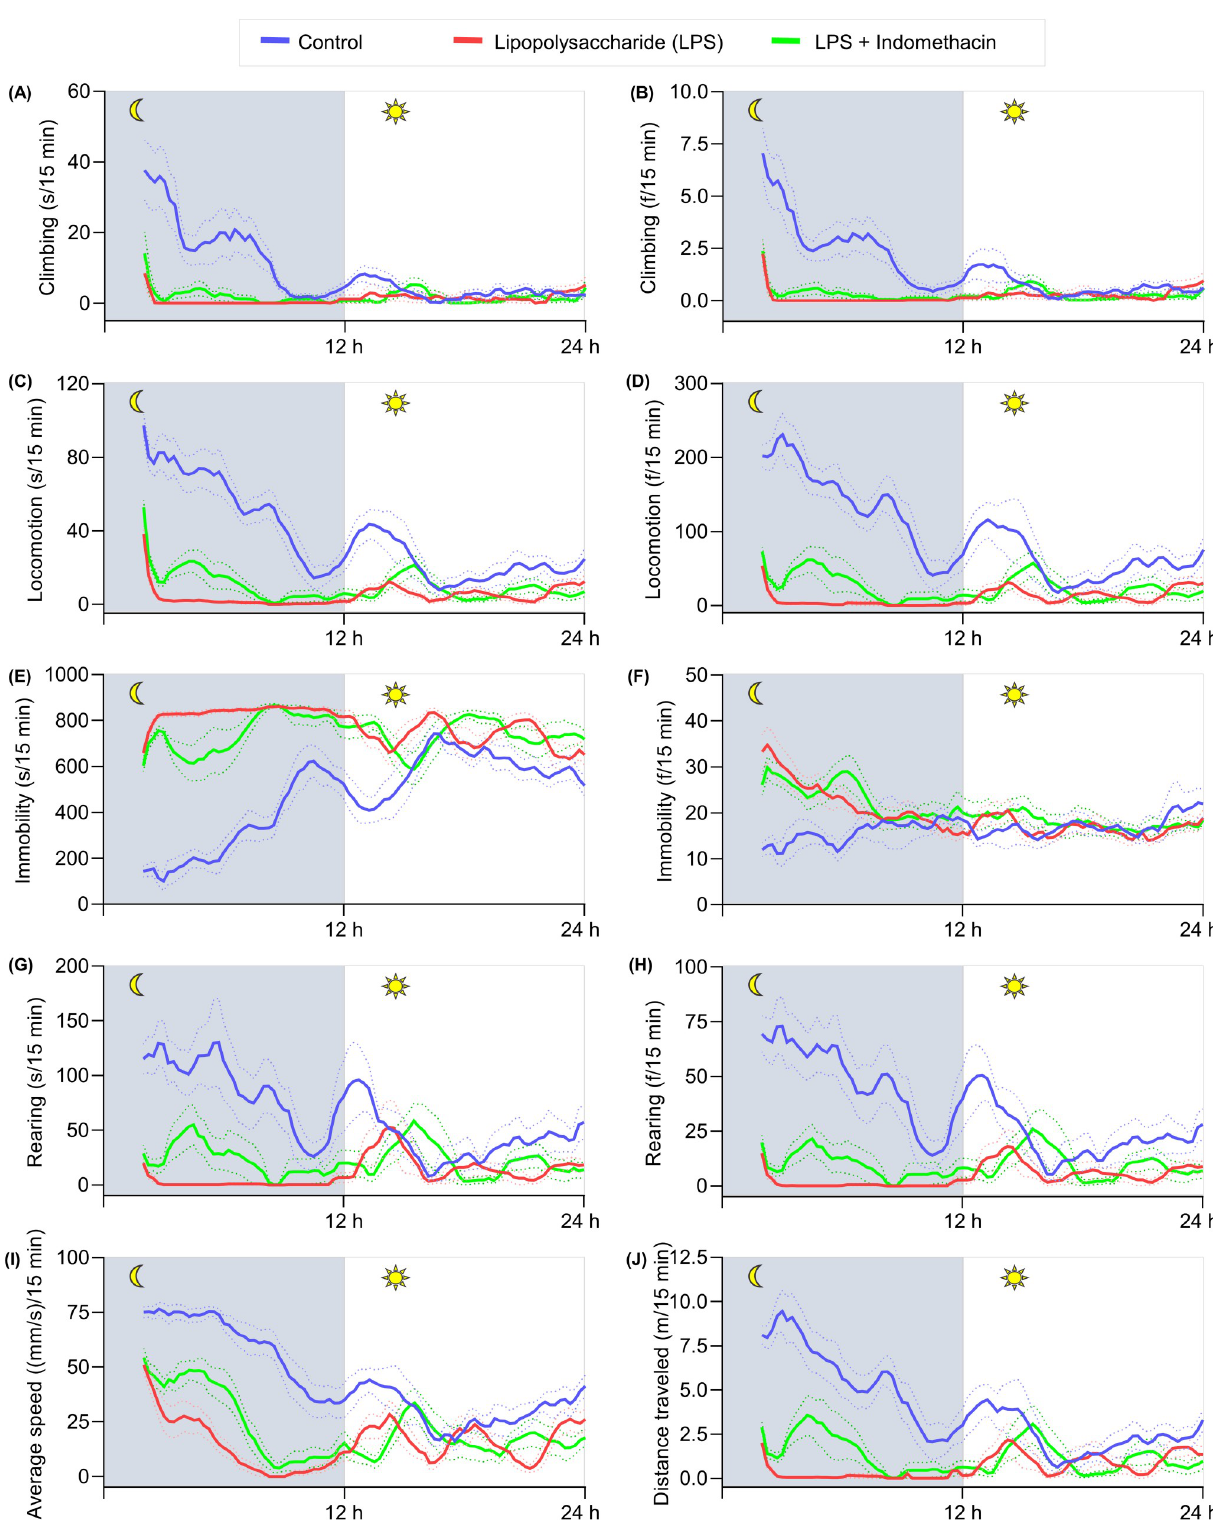
Fig 11. Time-series changes of home-cage behaviors in response to indomethacin treatment. Data are represented as a 2 h moving average for mean home-cage behaviors in each 15 min. Solid and dashed lines depict the mean and S.E.M of the moving average, respectively. N = 8 mice per group.